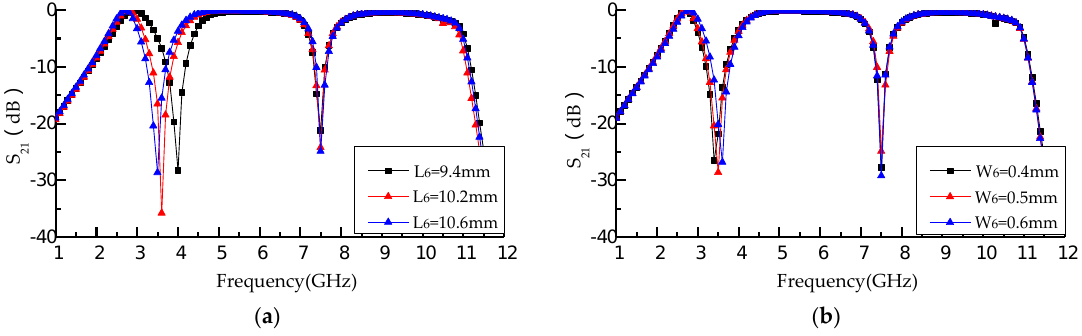
Figure 9. ( a ) Simulation results with different L 6 ( L 6 = 9.4 mm, f 01 = 4 GHz, L 6 =1 0.2 mm, f 01 = 3.6 GHz, L 6 = 10.6 mm, f 01 = 3.5 GHz); ( b ) Simulation results with different W 6 ( W 6 = 0.4 mm, f 01 = 3.4 GHz, W 6 = 0.5 mm, f 01 = 3.5 GHz, W 6 = 0.6 mm, f 01 = 3.6 GHz).